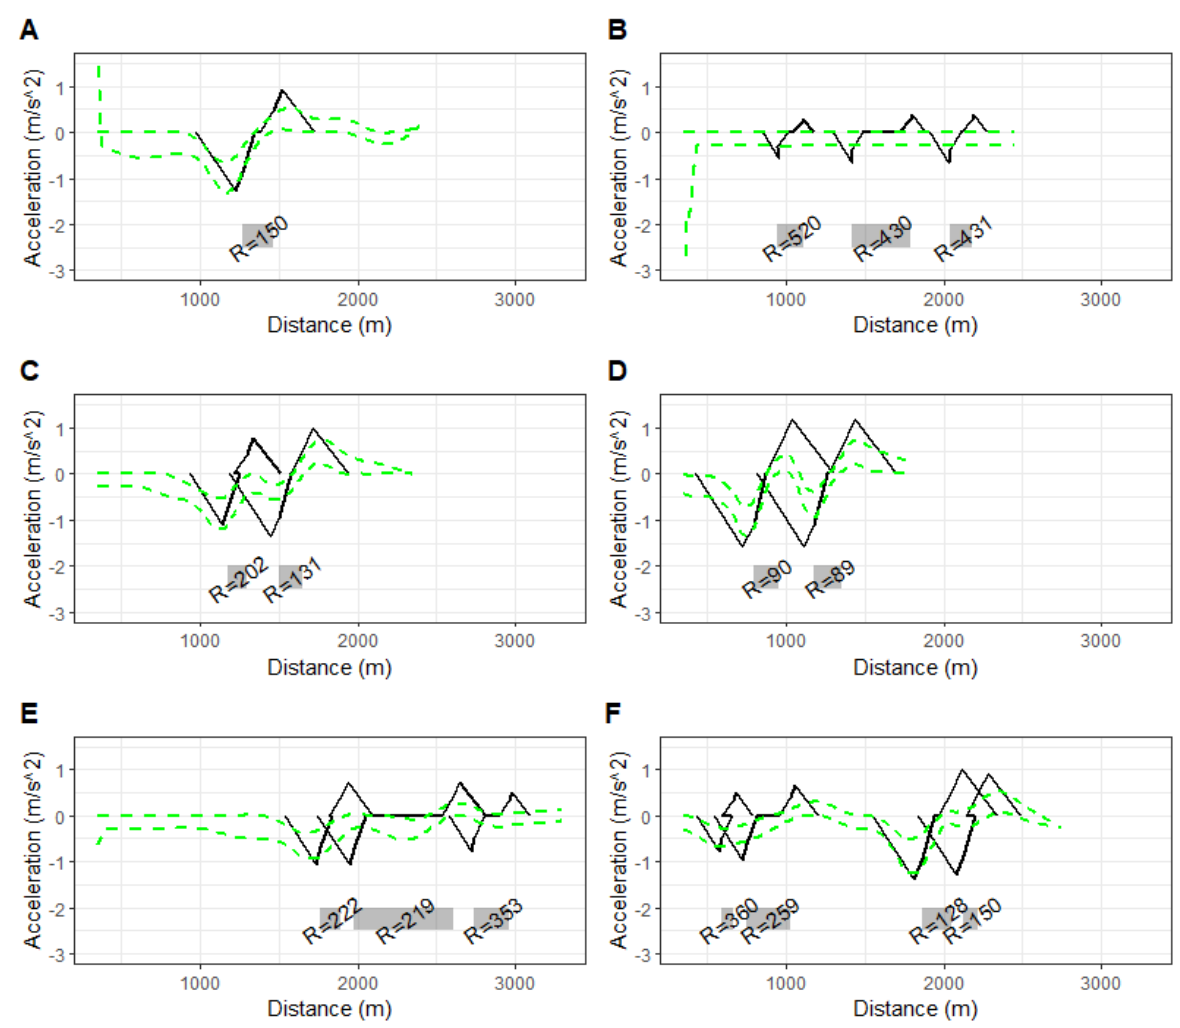
Figure 11. Observed and predicted acceleration profiles; green dashed lines are the observed accelerations at 15 th and 85 th percentile, the black lines are the predicted acceleration profiles per curve. Curve radii in a grey box representing the position of the curve. These acceleration profiles are taken from the same curves as presented in Figure